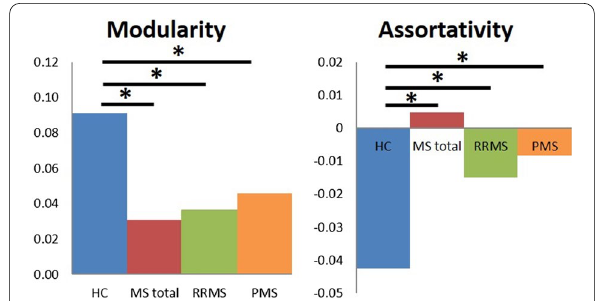
Fig. 2 Group differences of T1w MRI data without lesion filling in the global graph theoretical network parameters modularity and assortativity. Comparisons were made for HC versus MS total, HC versus RRMS, HC versus PMS, and RRMS versus PMS. Significant differences are indicated with an asterisk *